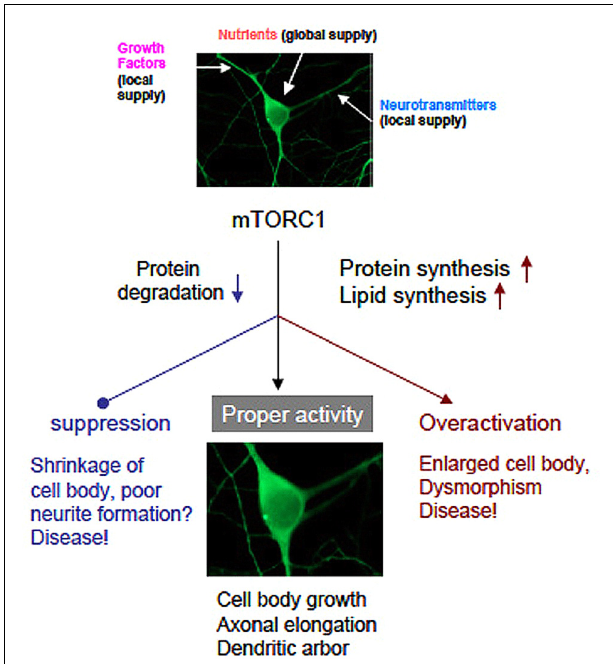
FIGURE 4 |A graphic of hypothetical neuronal development governed by mTORC1. Neurons receive nutrients globally and growth factors/ transmitters locally. Both inputs coordinately activate mTORC1 that leads normal neuronal development. Suppression or overactivation of mTORC1 result dysregulation of neuronal morphology and function. (note that photographs of a neuron was image